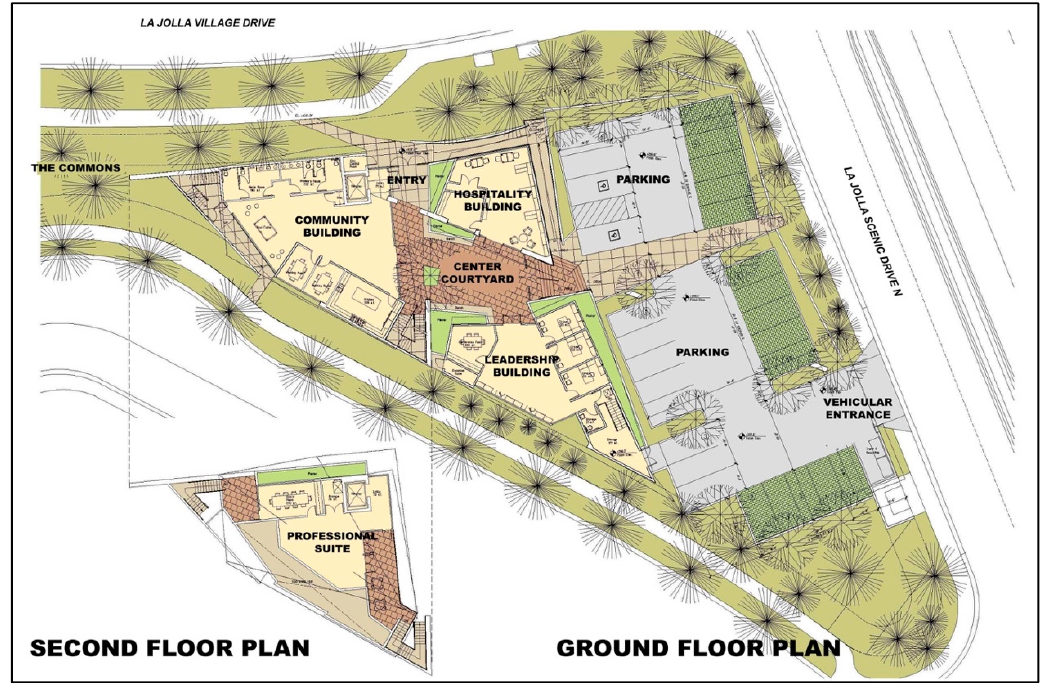
Figure 18. Site and Building Plans, Glickman Hillel Center at UCSD. Image Credits: © M. W. Steele Group, used by permission.